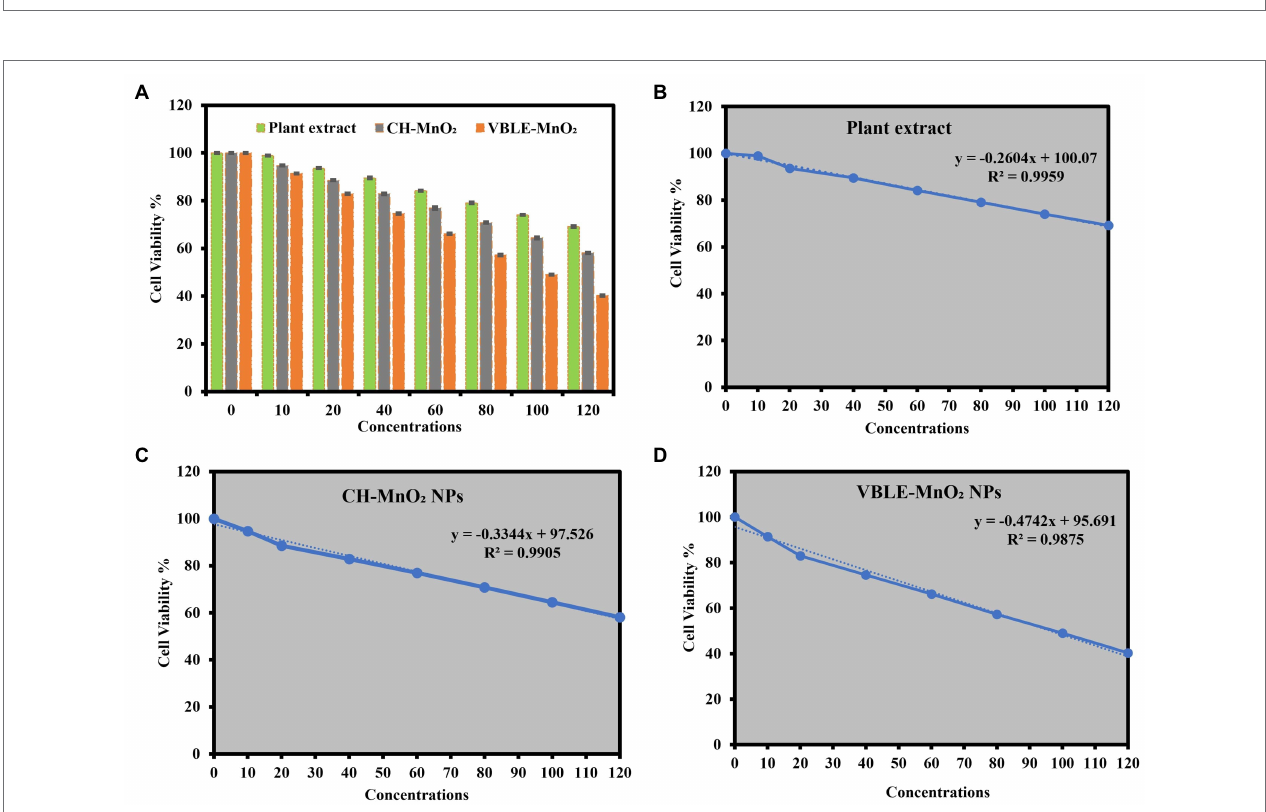
FIGURE 9 | (A) Cytotoxic potential in terms of cell viability percentage against MCF-7 carcinoma cells treated with V. betonicifolia leaves extract, CH-MnO 2 NPs, and VBLE-MnO 2 NPs. Linear plot and regression coefficient between the cell viability % of the MCF-7 carcinoma cells with different concentrations of (B) V. betonicifolia leaves extract, (C) CH-MnO 2 NPs, and (D) VBLE-MnO 2